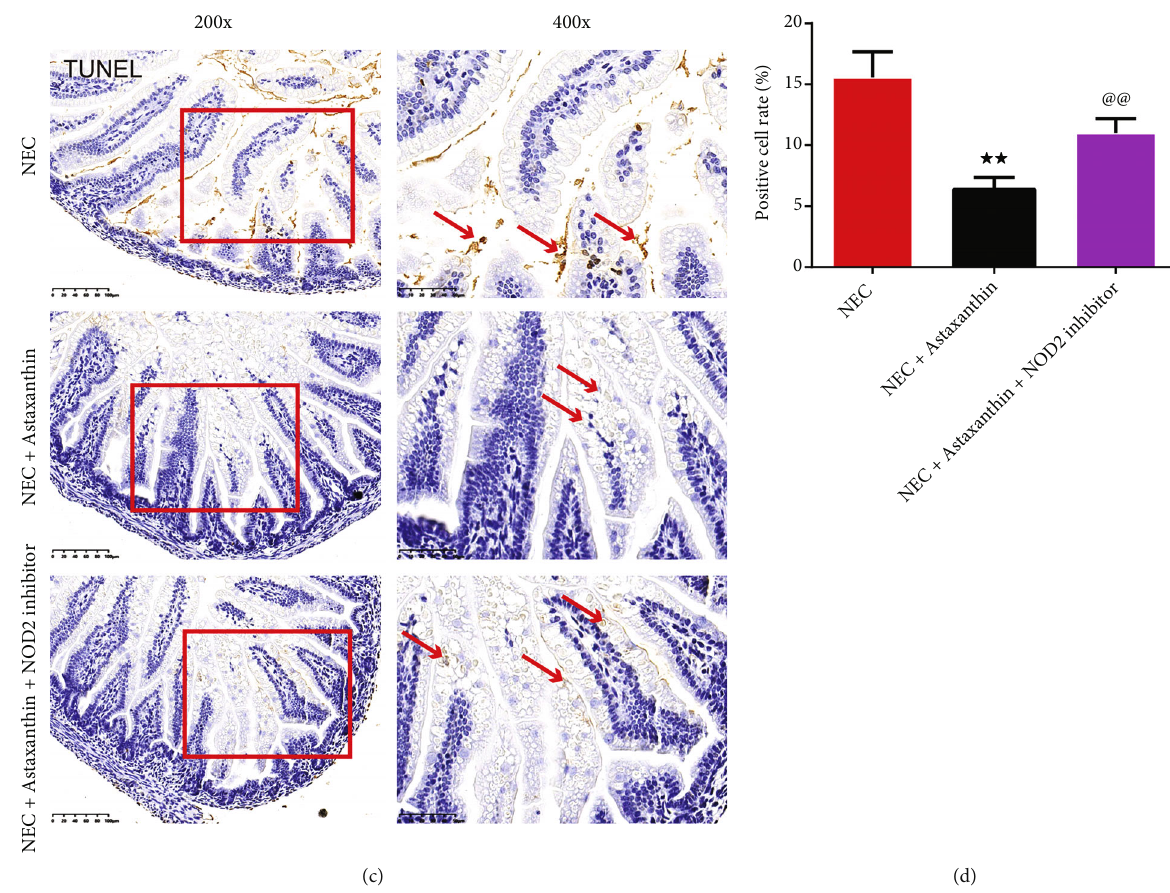
Figure 5: NOD2 inhibitor o ff set the protective e ff ect of Astaxanthin on intestinal tissues in NEC rats. (a and b) The histomorphology in intestinal tissues in rats was observed by HE staining (magni fi cation × 200, 400), and the HE scores were calculated in each group, n = 6 in each group. (c and d) The apoptotic cells of intestinal tissues in rats are stained by the TUNEL kits, and the positive cell rates were calculated in each group (magni fi cation × 200, 400), n = 6 in each group, ★★ P < 0 : 01 vs. NEC group, @ P < 0 : 05 , @@ P < 0 : 01 vs. NEC +Astaxanthin